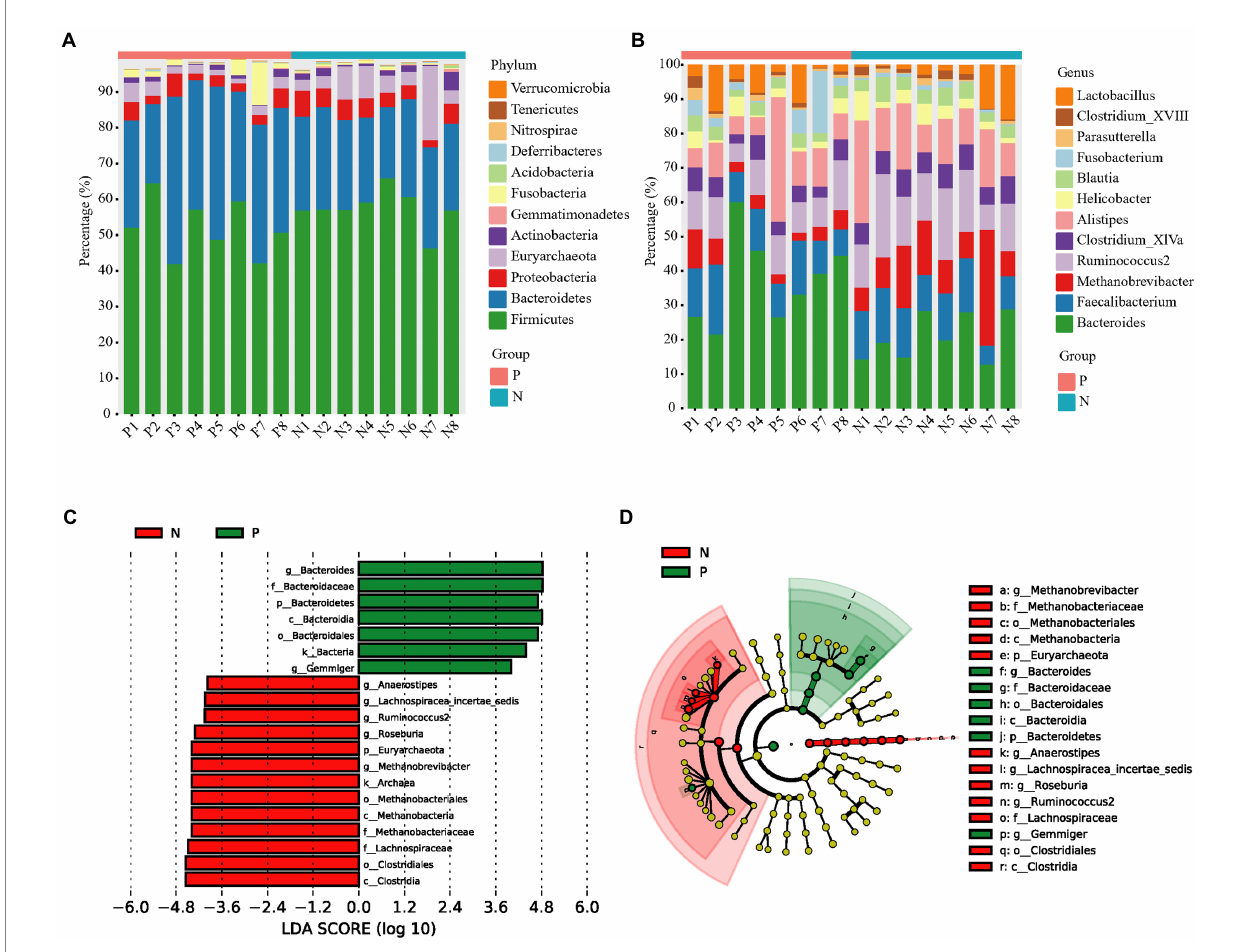
FIGURE 4 The relative abundance of cecal bacterial composition at the phylum and genus level and LefSe analysis of cecal microbiota. (A) The Relative abundance of cecal bacterial composition at phylum level; (B) The Relative abundance of cecal bacterial composition at genus level; (C) and (D) LEfSe analysis of cecal microbiota. The threshold of the logarithmic LDA score was 3.5. P = feather pecker, N =